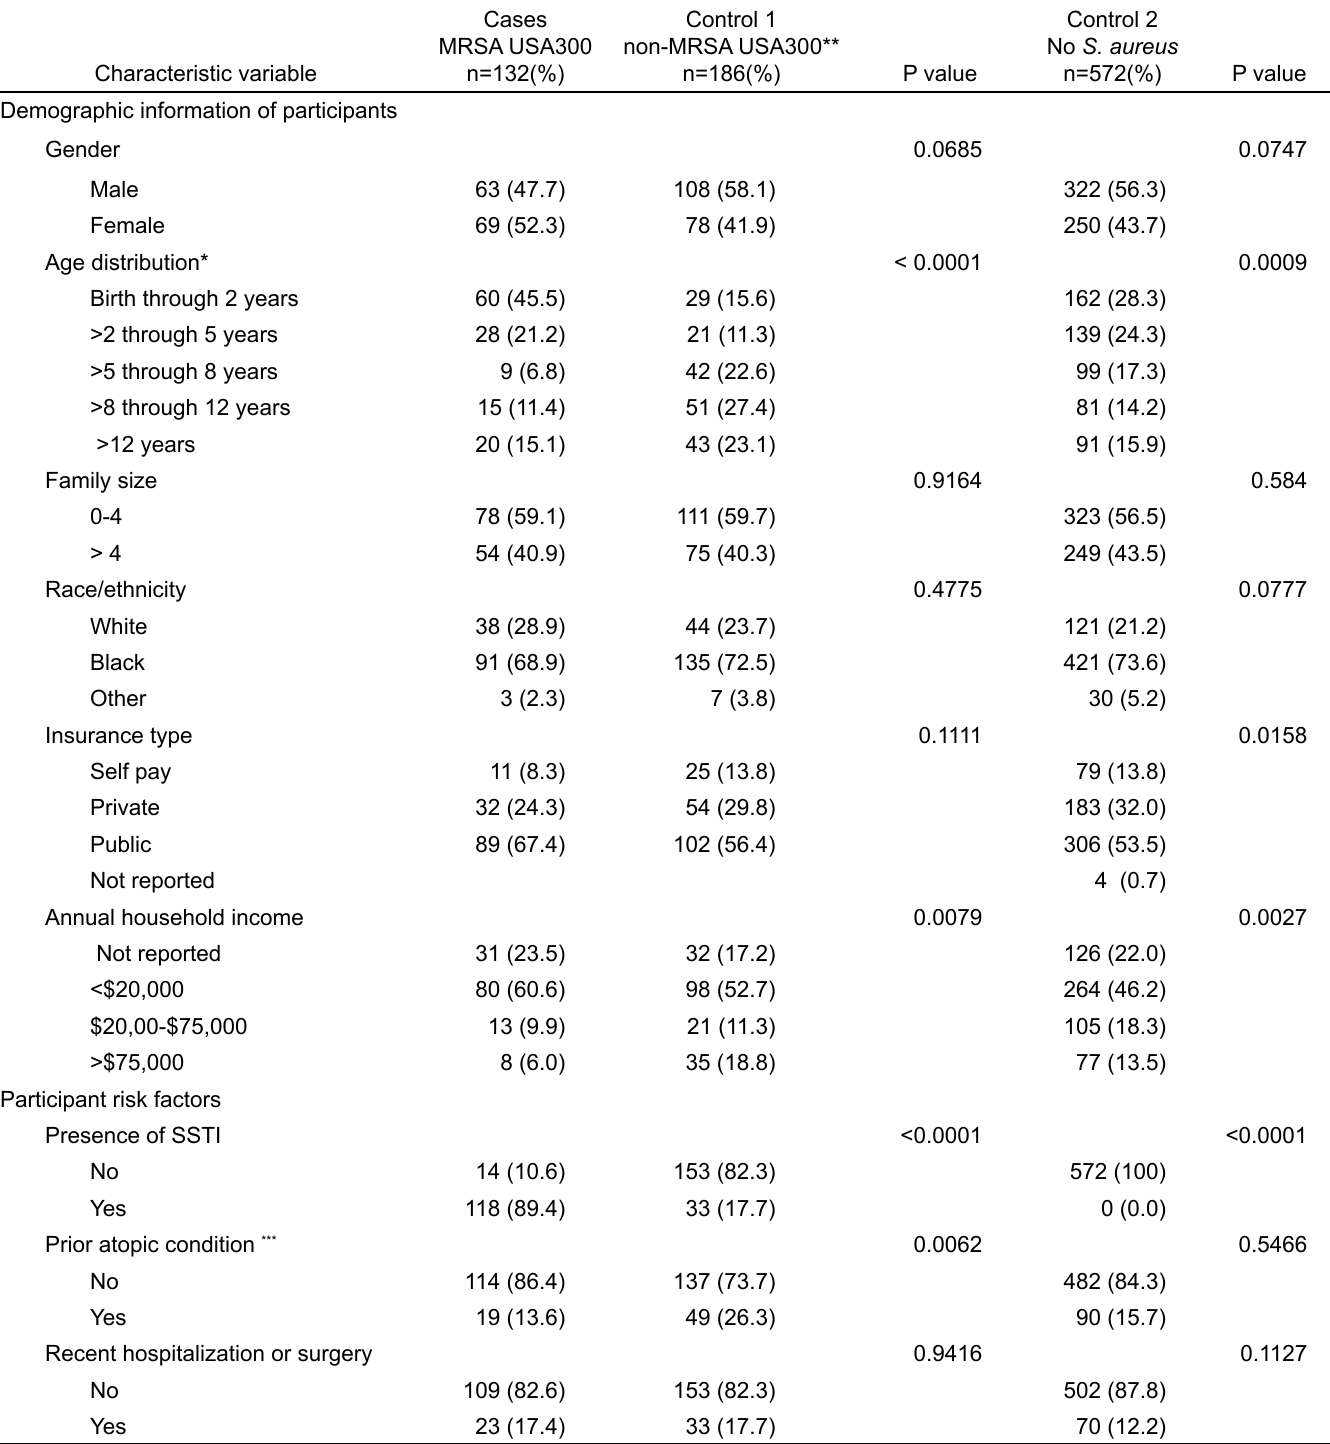
Table 1. Descriptive population characteristics of patients in study of risk of skin and soft tissue infections in children who are MRSA